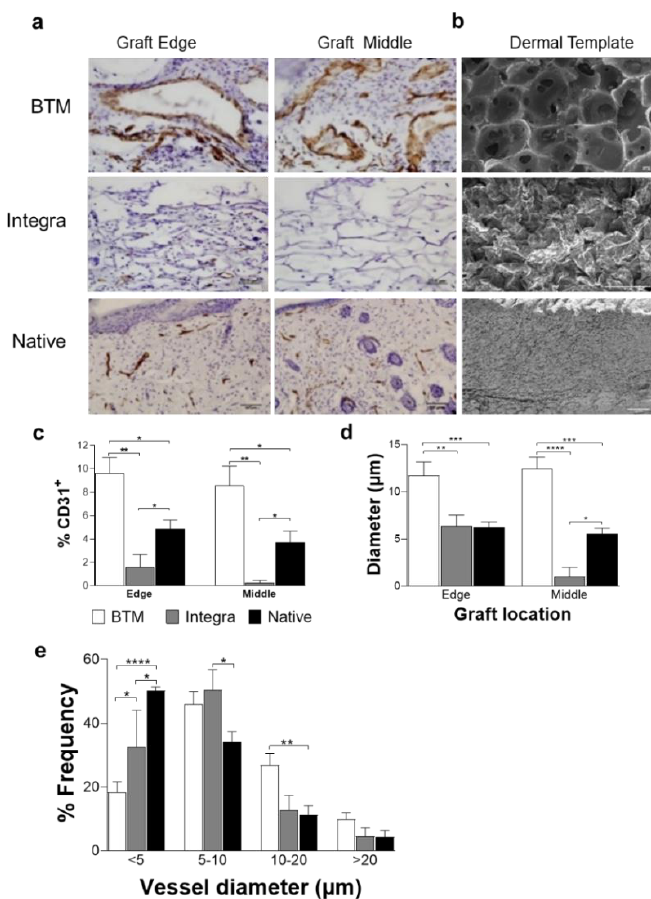
Figure 1. Detection of endothelial cells in mouse grafts. ( a ) CD31 positive endothelial cells were detected in grafts using IHC staining. Representative images of BTM, Integra ® , and allogenic native skin grafts are presented (scale bar 50 µ m). ( b ) SEM images of BTM, Integra ® , and native mouse skin (scale bar 100 µ m). ( c ) CD31 staining on graft edge and the middle was quantified and normalised for image area. CD31 staining was used to score vessel diameter ( d ), and the frequency of di ff erent vessel diameters ( e ). Values represent mean +/ - SEM in each group ( n = 4 mice per group) and analysed using unpaired t-test. * = p ≤ 0.05, ** = p ≤ 0.01, *** = p ≤ 0.001, **** = p ≤